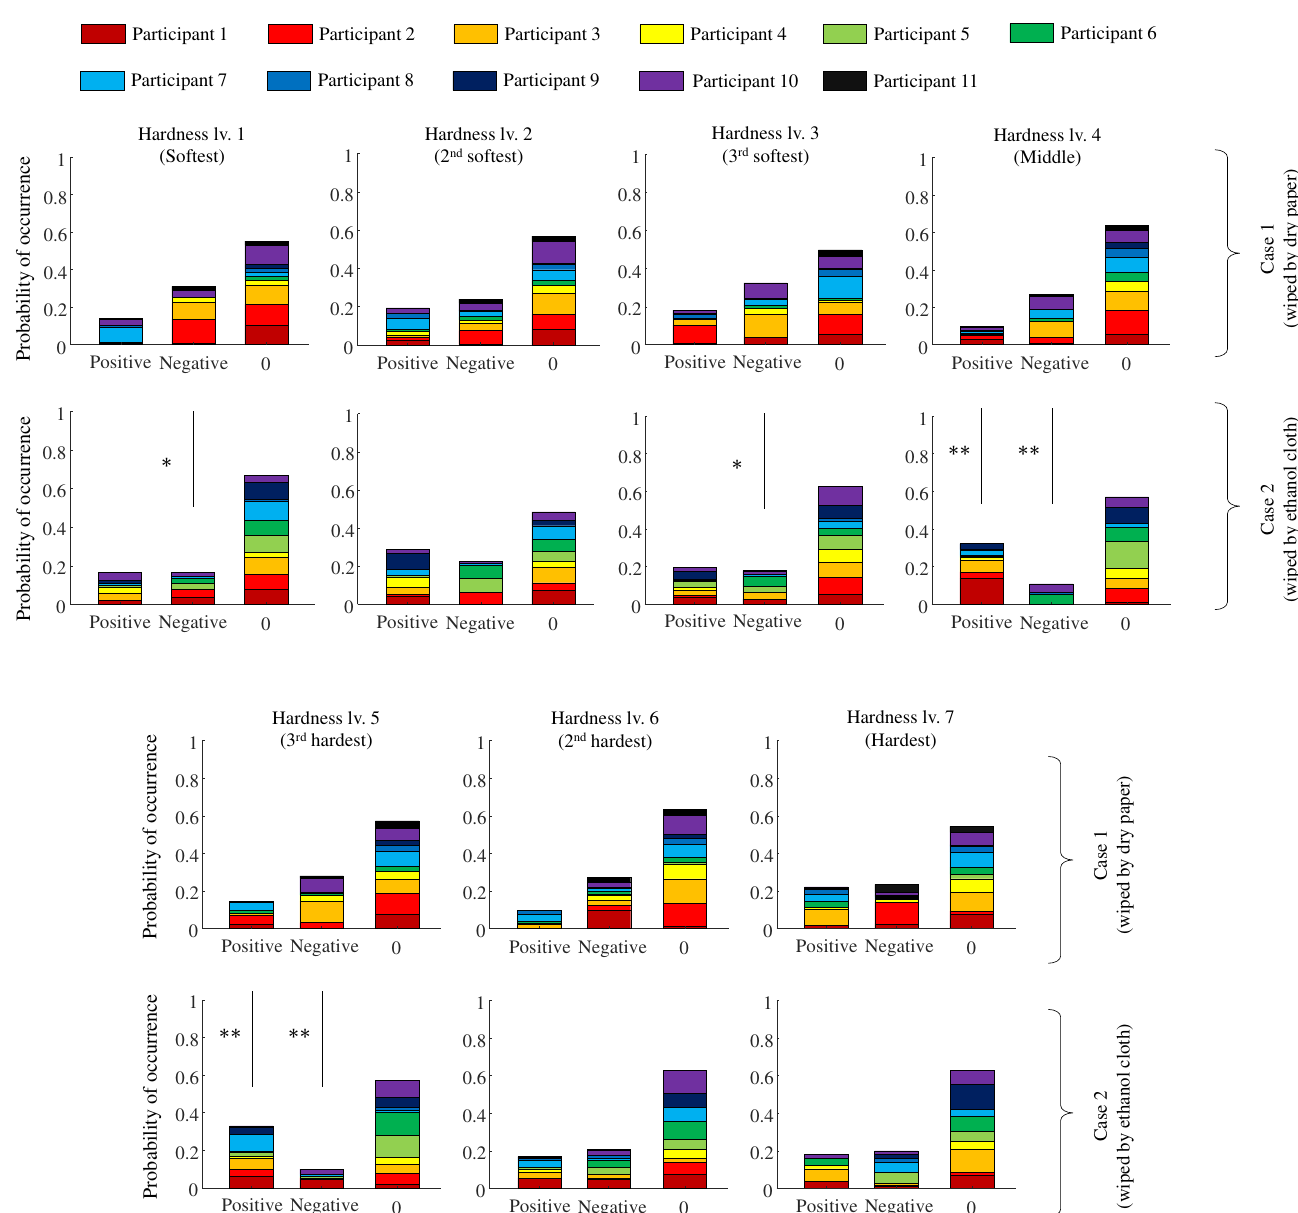
Figure 7. Probability of occurrence of positive, negative, and insignificant β values. The upper and lower sections represent the results under case 1 (wiped by a dry cloth) and case 2 (wiped by ethanol), respectively. Cohen’s d = 0.8. Asterisks * and ** indicate statistical differences in the proportions between cases at p < 0.05 and p < 0.01, respectively. The sum of the proportions for all individuals is 1. Note that the number of slides differs from participant to